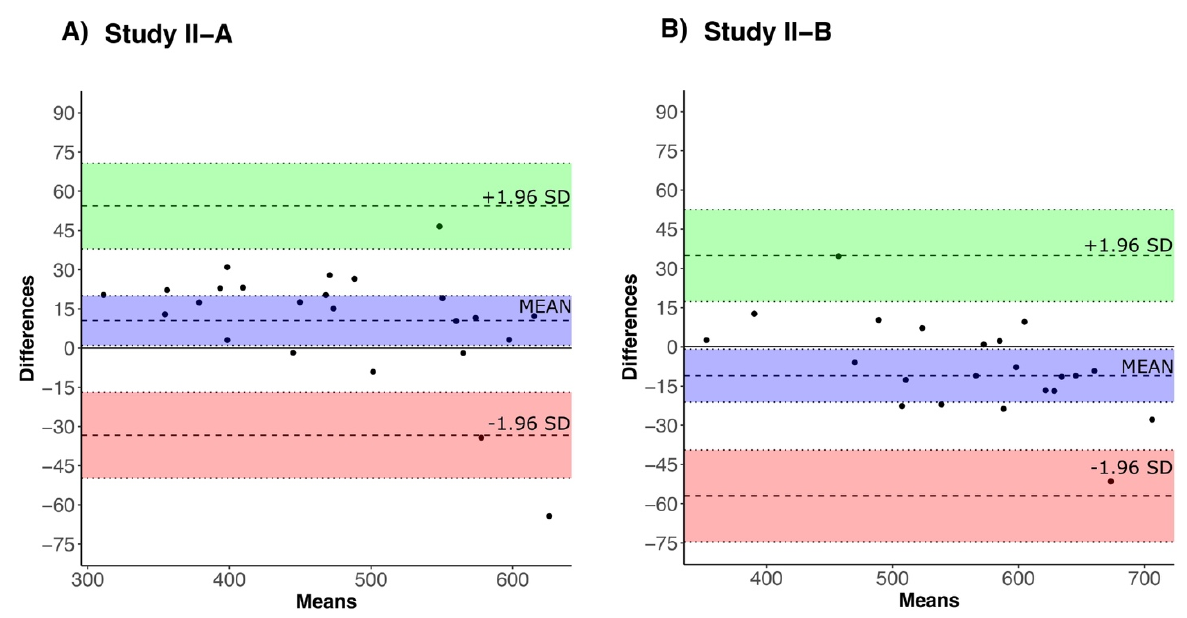
Figure 4. Bland-Altman plot for agreement between a manually calculated walk distance and walk distance estimates using the proposed algorithm for 6MWT in ( A ) Study II-A (15 m walkway distance) and ( B ) Study II-B (20 m walkway distance). Bias (mean), upper (+1.96 SD) and lower ( − 1.96 SD) limit agreement are represented by blue, green, and red colors, respectively.